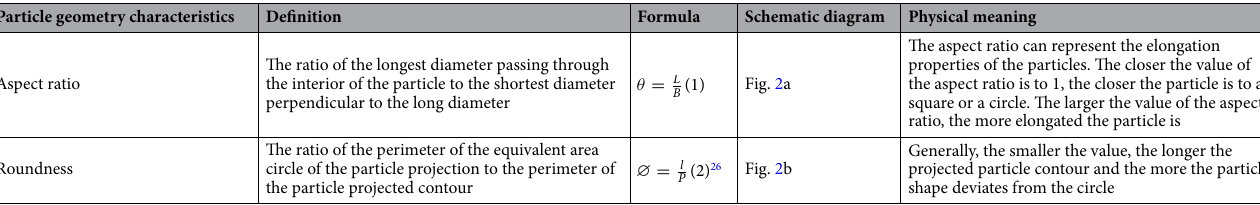
Table 2. Definition and schematic diagram of particle aspect ratio and roundness. ( θ : aspect ratio; L : longest diameter inside the particle; B : shortest diameter perpendicular to the longest diameter; ∅ : roundness; A : π r 2 (3)); l : perimeter of the equivalent area circle of the particle projection projected area of particles ( A = 2 π r (4)); r : equivalent circle radius of particles; P : perimeter of the particle projected contour; Substitute ( l 2 √ π A = formula (3) and (4) into formula (2) to obtain the roundness formula: ∅ P ). =